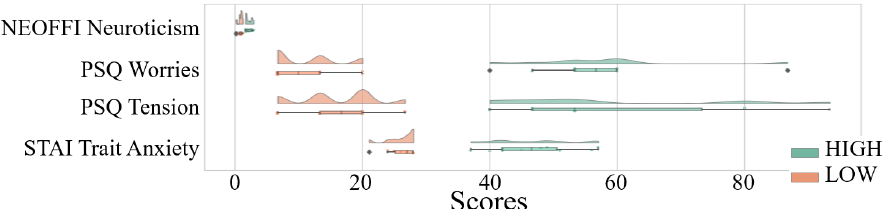
Figure A1. Distribution of neuroticism (NEO-FFI), worries (PSQ), tension (PSQ), and STAI trait anxiety (STAI-G-X2) for the selected 10 HIGH and 10 LOW stress-susceptible groups. Clear distinction of participants’ responses in HIGH versus LOW stress-susceptible groups is evident in this figure (Appendix C.4 for analysis of significant differences between participants’ responses in HIGH versus LOW stress-susceptible